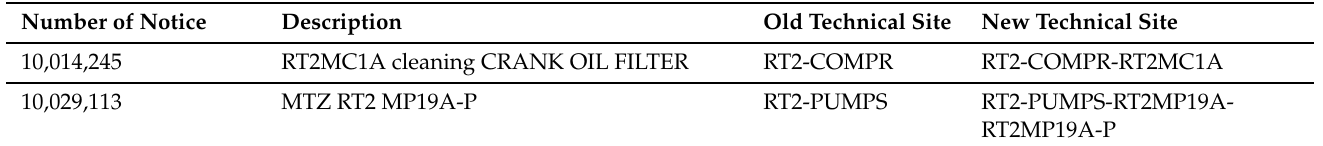
Table 5. Example of reconstruction site using the fourth methodology when the technical site contains